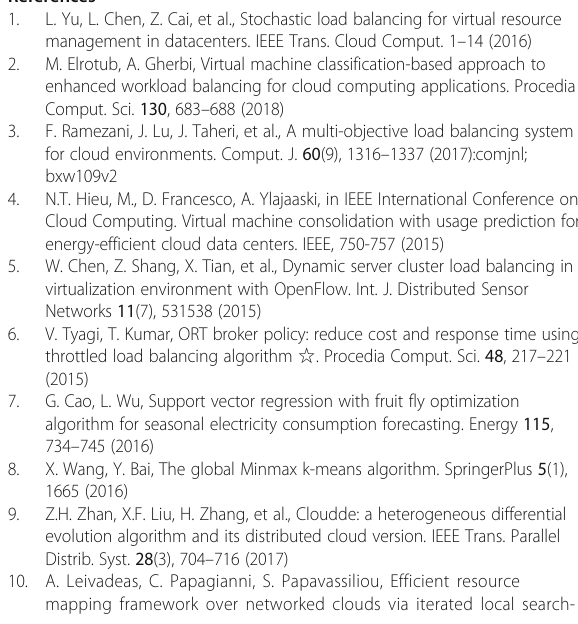
80%; the maximum number of virtual machine migra- tion is reduced by 94.5%; the maximum energy con- sumption of data center is reduced by 49.13%; and the goal of load balancing is